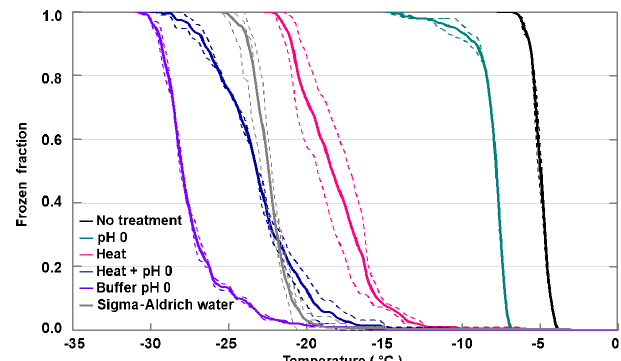
Figure 5. Stress treatments performed with apoferritin batch 1 (0.34mgmL − 1 ). Frozen fraction as a function of temperature for apoferritin in pH 0 buffer, after heating an apoferritin solution in SA water for 5h at 110 ◦ C and after heating an apoferritin solution at pH 0 for 5h at 110 ◦ C. For comparison, freezing of SA water and of the buffer solution at pH 0 is also shown. Two DRINCZ experi- ments were performed for each concentration (dashed lines) and the mean is shown as the thick solid